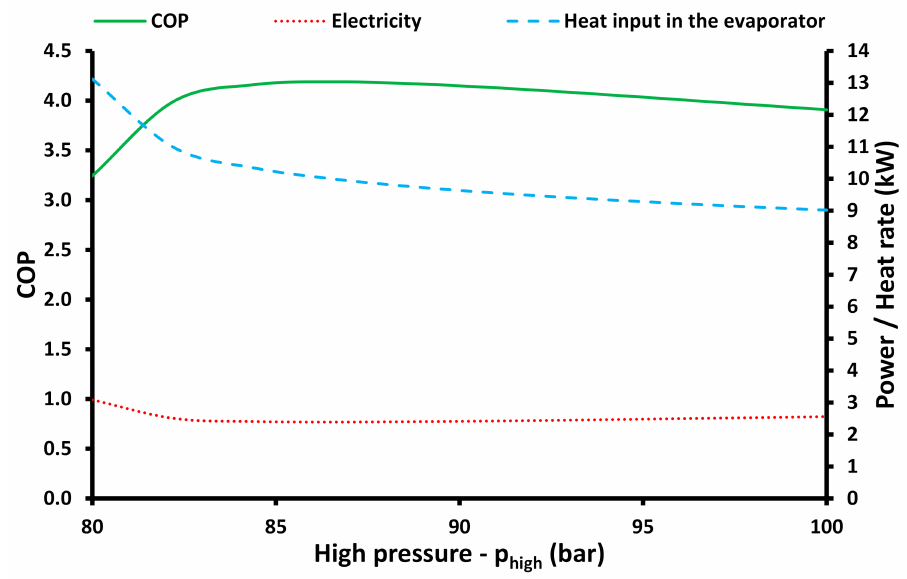
Figure 4. The impact of the high pressure on the COP, electricity consumption and heat input in the